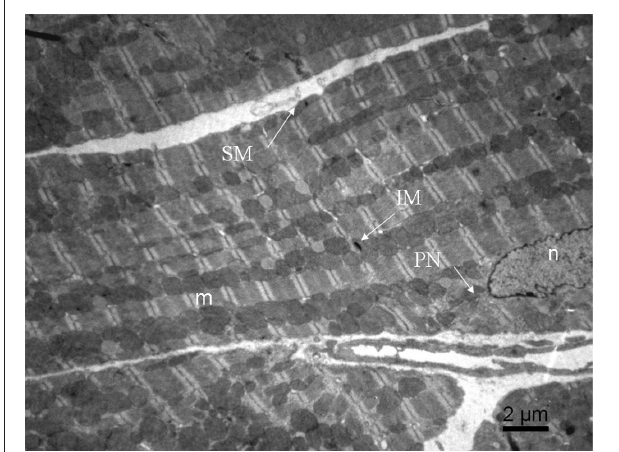
FIGURE 1 | Image of adult mouse cardiomyocyte obtained by electron microscopy. Three subpopulations of mitochondria are observed: intermyofibrillar mitochondria (IM) along the contractile proteins, the subsarcolemmal mitochondria (SM) just beneath the sarcolemmal and perinuclear mitochondria (PN) around the nucleus. m, myofibrils; n,